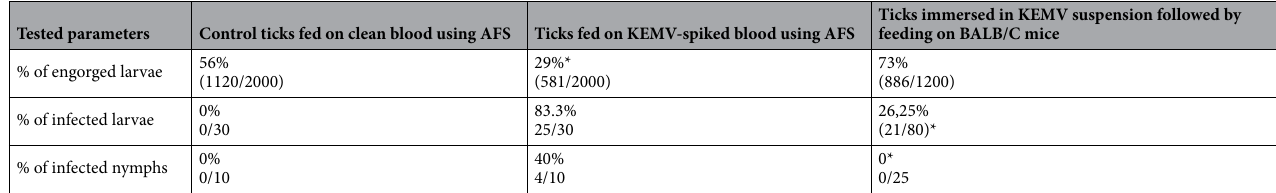
Table 2. Engorgement rates of larvae and KEMV infection in engorged larvae and nymphs infected at larval stage after artificial feeding (AFS) or immersion techniques (khi-2 test, alpha = 5%, *: p value <